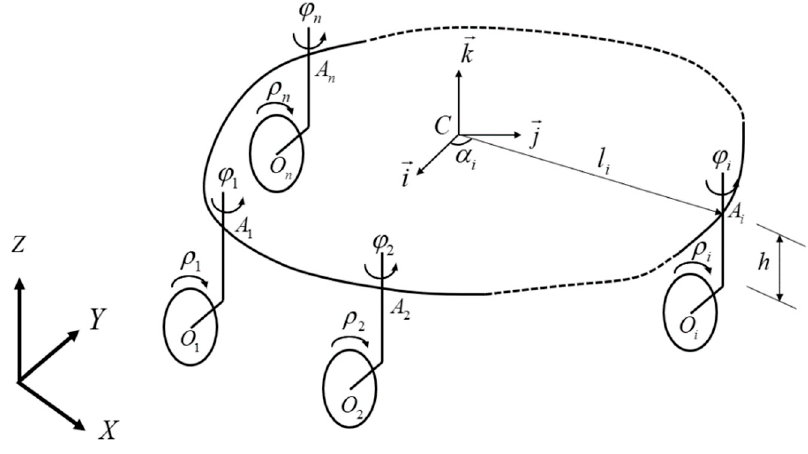
Figure 3. Modular design of the OMR with n PCWs.